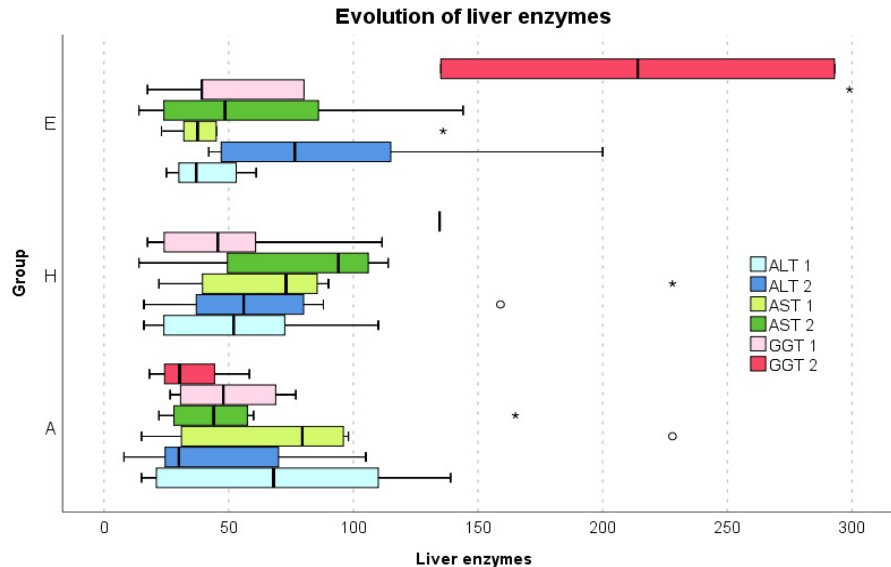
Figure 4. Evolution of some liver enzymes in the two groups on the three Brixia days: A, H and E. All values are above the normal limits. ◦ = outlier value, * = extreme outlier value, | = median All values are above the normal limits. o = outlier value, * = extreme outlier value, l =median value. A—admittance day (Brixia A), H—the day of highest lung involvement of COVID-19 in the ICU (Brixia H), E—the end day of hospitalization in the ICU (Brixia E), ALT—alanine aminotransferase, AST—aspartate aminotransferase, GGT—gamma glutamyl traspeptidase, 1—spring group, 2—au- tumn group.